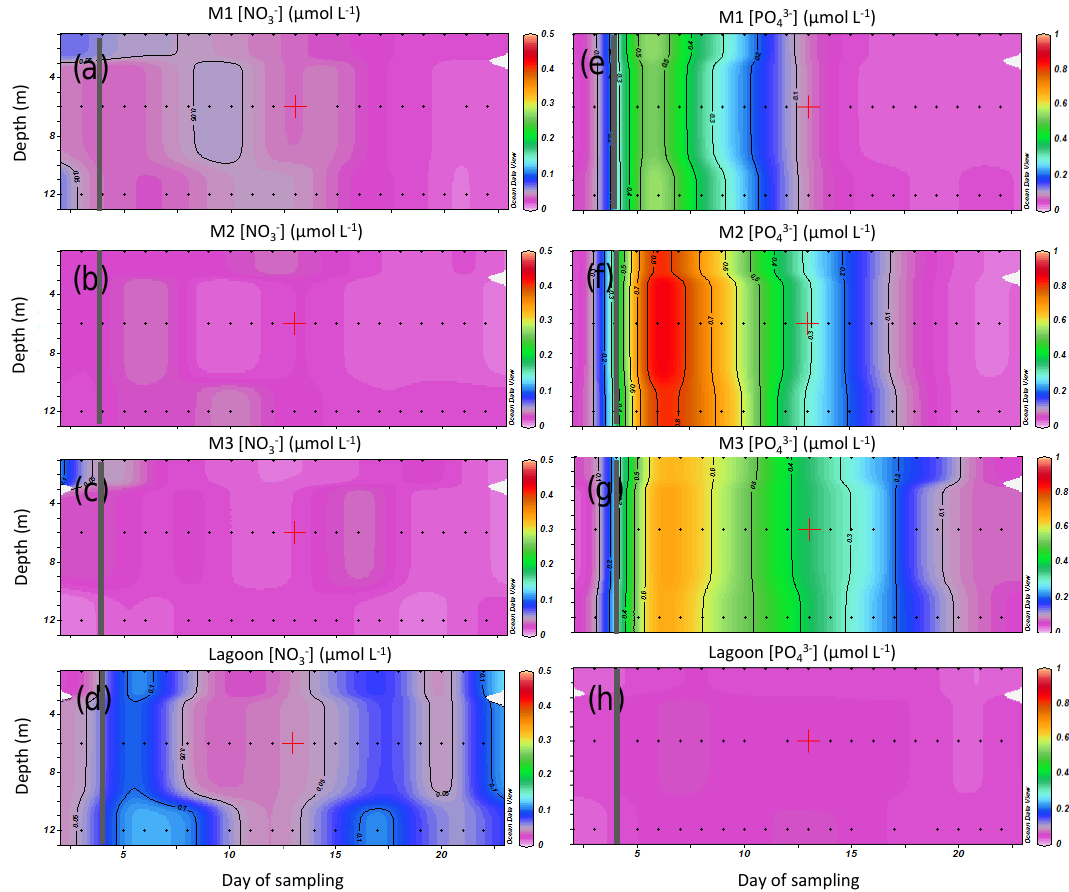
Figure 5. Horizontal and vertical distributions of NO − grey bars indicate the timing of the DIP spike on day